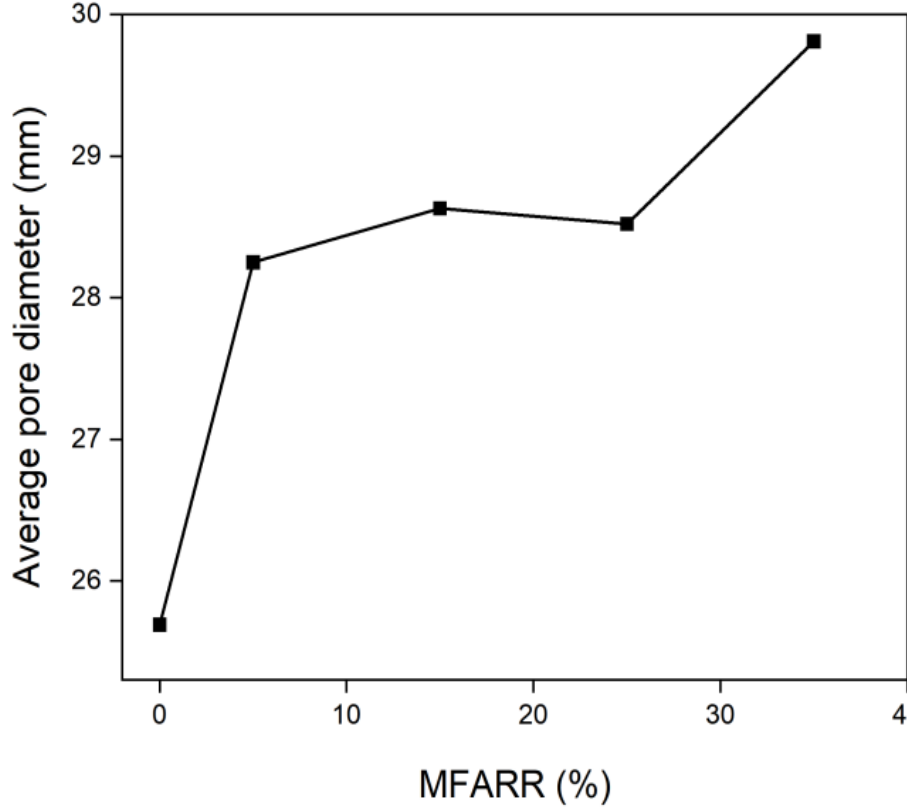
Figure 3. Influence of MFARR on the average pore diameter of the matrix. Table 4. Heavy metal leaching results and landfill limits.